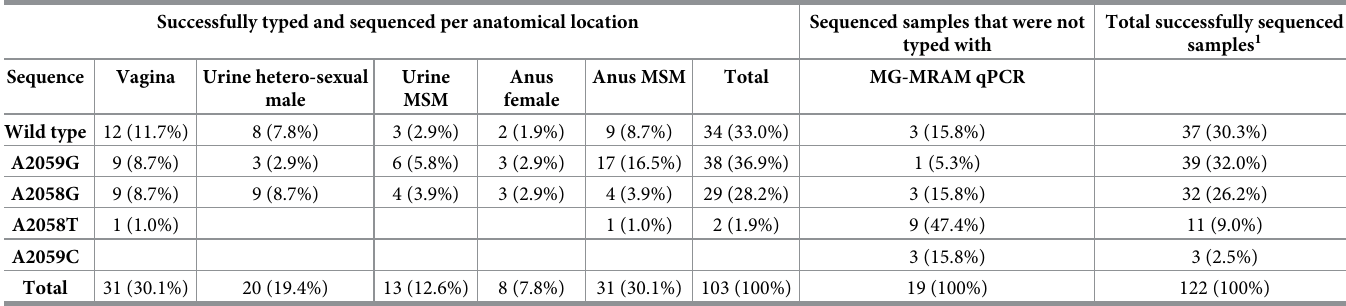
Table 2. Type of 23SrRNA mutations in samples from different anatomical locations that were MG positive in the MG-TMA. Successfully typed and sequenced per anatomical location